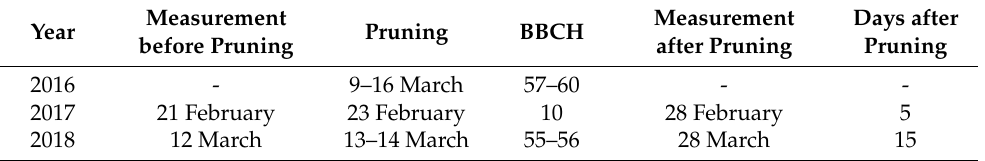
Table 2. Dates of the canopy dimension measurements before and after pruning and dates of the pruning and Biologische Bundesanstalt, Bundessortenamt and Chemical industry (BBCH) citrus developmental stage.